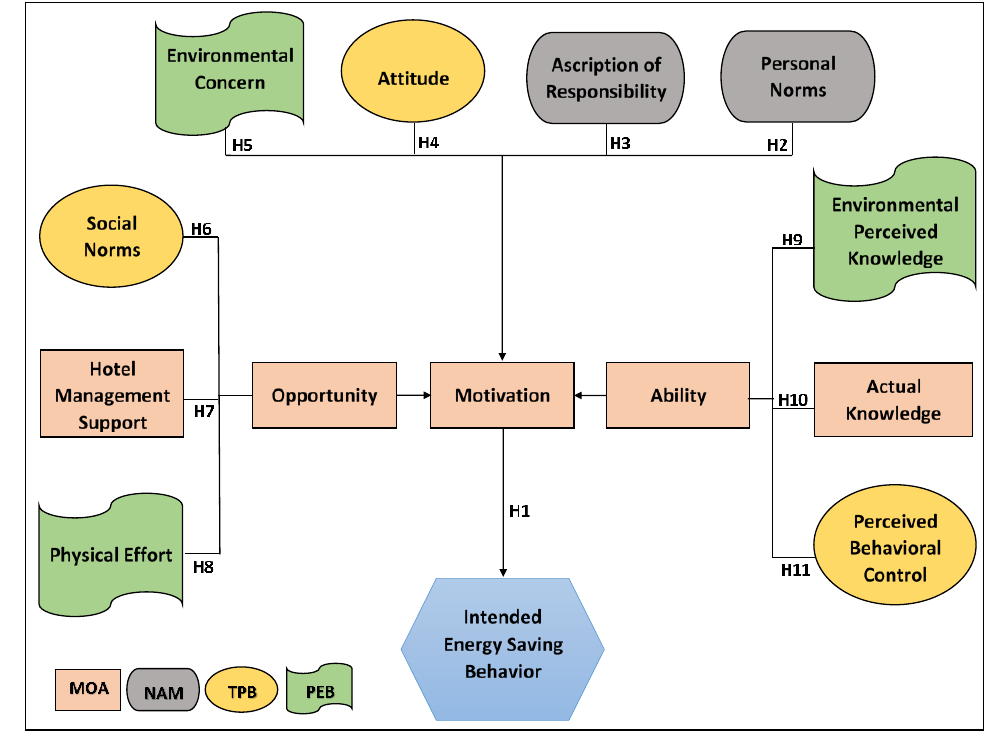
Figure 1. The Integrated Energy-Use Framework.